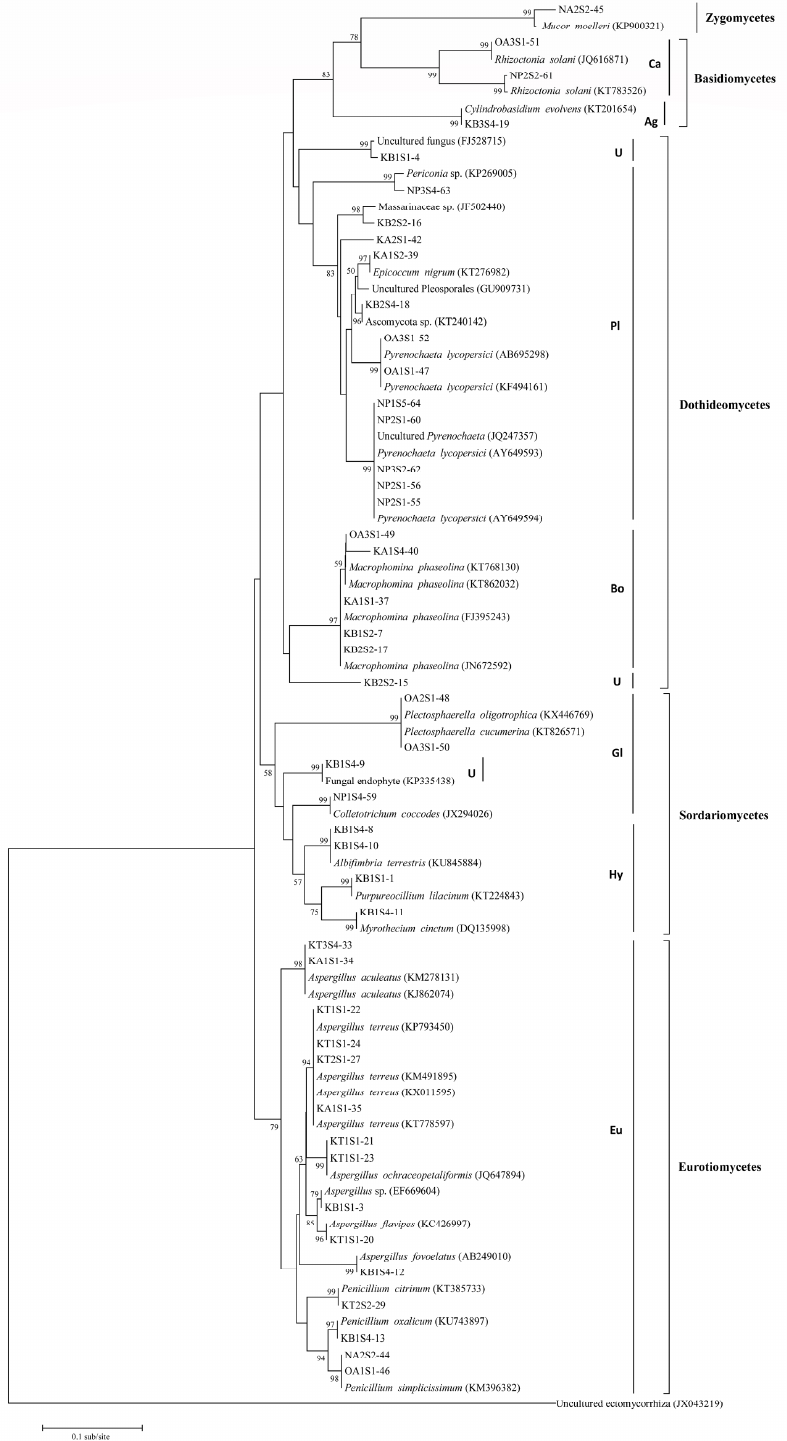
Figure 3. Phylogram of 46 rDNA ITS sequences of root endophytic fungi and their closest BLAST matches based on neighbor-joining analysis. Bootstrap values of >50% are shown at branching points. Ca: Cantharellales; Ag: Agaricales; U: Unknown; Pl: Pleosporales; Bo: Botryosphaeriales; Gl: Glomerellales; Hy: Hypocreales; and Eu: